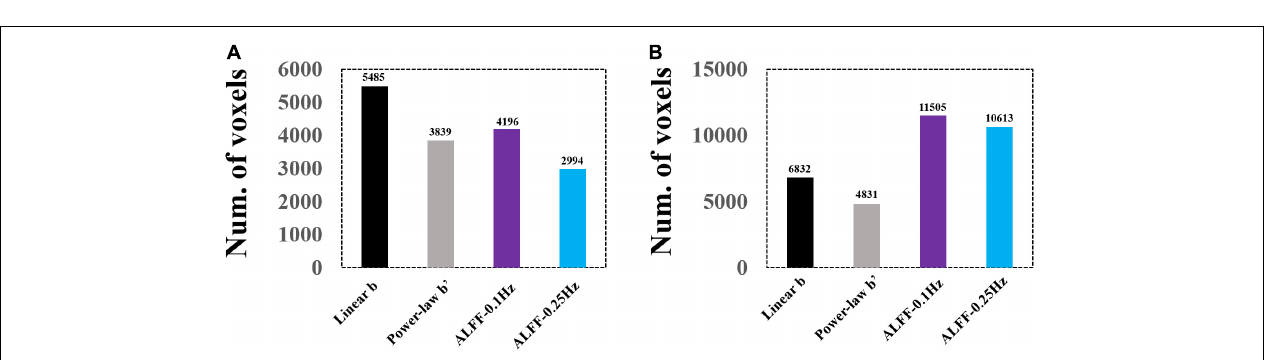
FIGURE 9 | Voxel numbers of GRF-corrected differences between EC and EO conditions using group and individual Z-transformation. Panel (A) shows the number of voxels surviving GRF correction for group Z-transformation. Panel (B) shows the number of voxels surviving GRF correction for individual